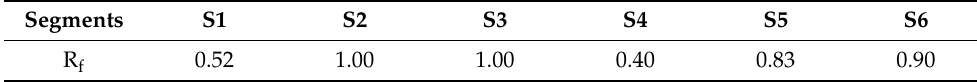
Figure 18. Hangzhou Qianjiang New City skyline’s skyline rhythm index. Table 7. Skyline rhythm index data for each